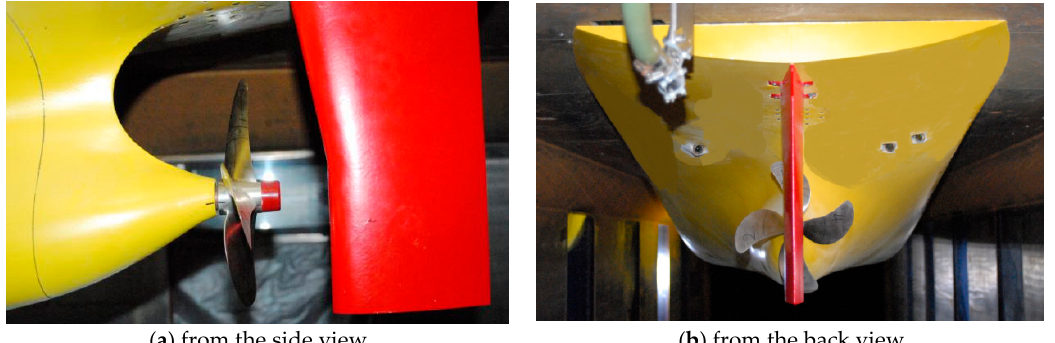
Figure 1. YUPENG ship and propeller geometry model.